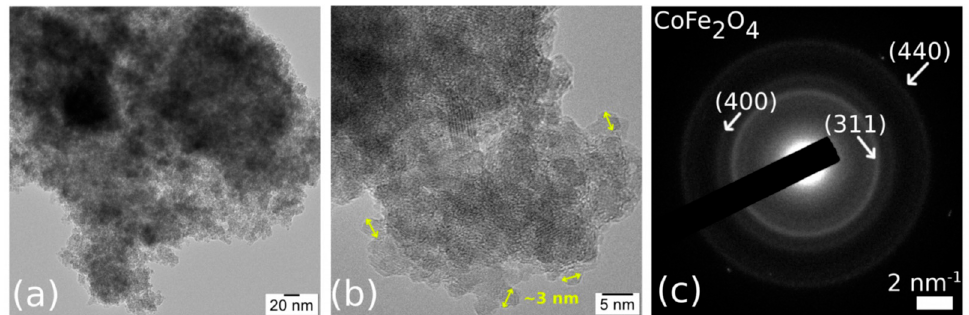
Figure 5. TEM image ( a ), High-Resolution Transmission Electron Microscopy (HRTEM) image ( b ), and Selected Area Electron Diffraction (SAED) ( c ) of the CoFe 2 O 4 sample.